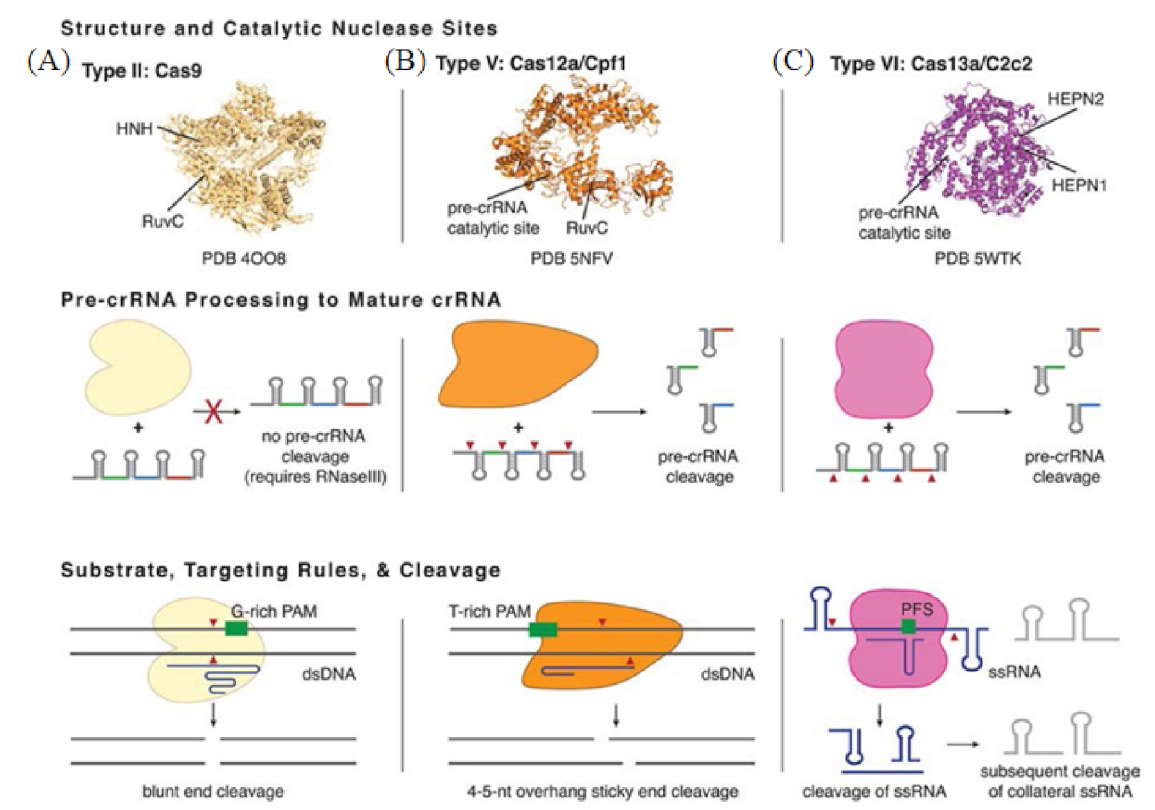
Figure 5. Basic structure and functions of Class 2 CRISPR-Cas Types. ( A ) The representative of Type II is Cas9 from Streptococcus pyogenes. ( B ) The representative of Type V is Cas12a from Francisella novicida U112. ( C ) The representative of Type VI is Cas13a from Leptotrichia shahii. Reprinted with permission from Ref. [96]. Copyright 2018, Pyzocha et